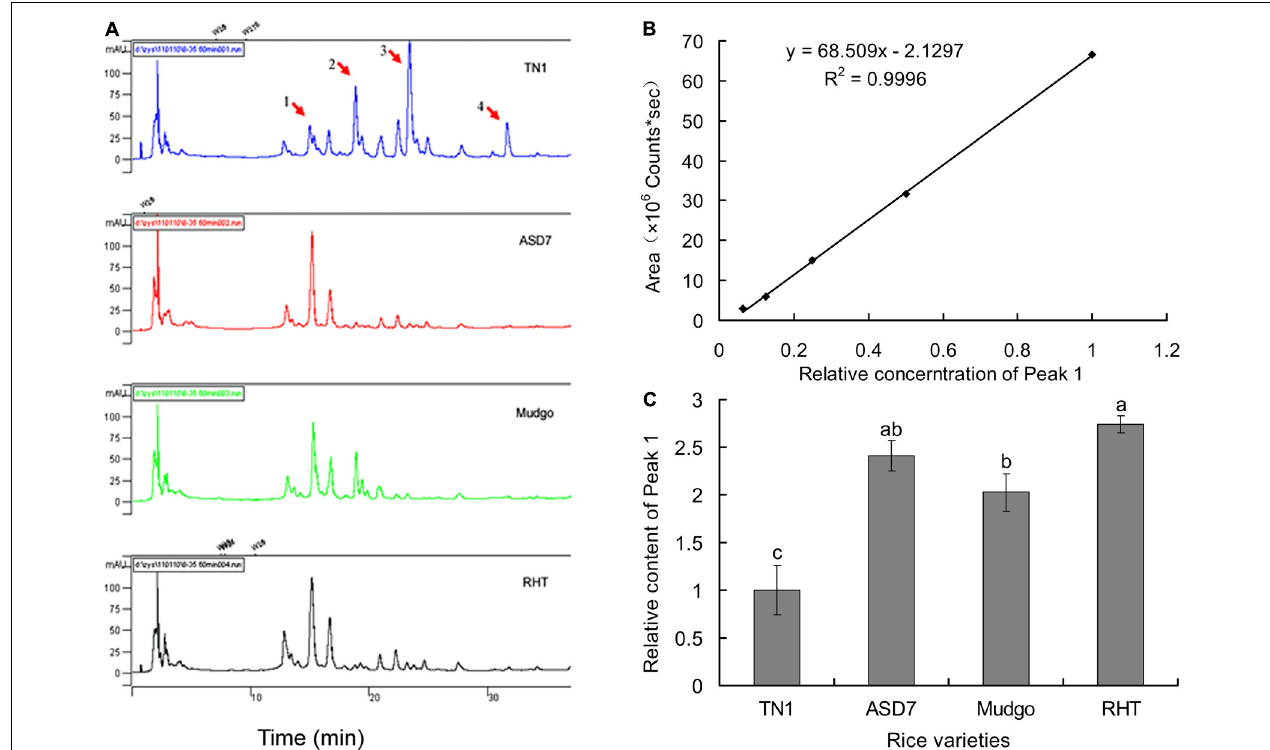
FIGURE 2 | Determination of Peak 1 related compound in rice flavonoids by HPLC. (A) HPLC fingerprints of flavonoids extract from different rice varieties. (B) A calibration curve constructed by plotting the peak-areas to the relative concentrations of Peak 1 related compound. (C) Relative content of Peak 1 related compound in flavonoids extract from different rice varieties, calculated according to the calibration curve in (B) . Data was analyzed by ANOVA with Tukey’s HSD tests and relative content with the same letter were not significantly different ( P < 0.05). Data were presented as means ± SD ( n =